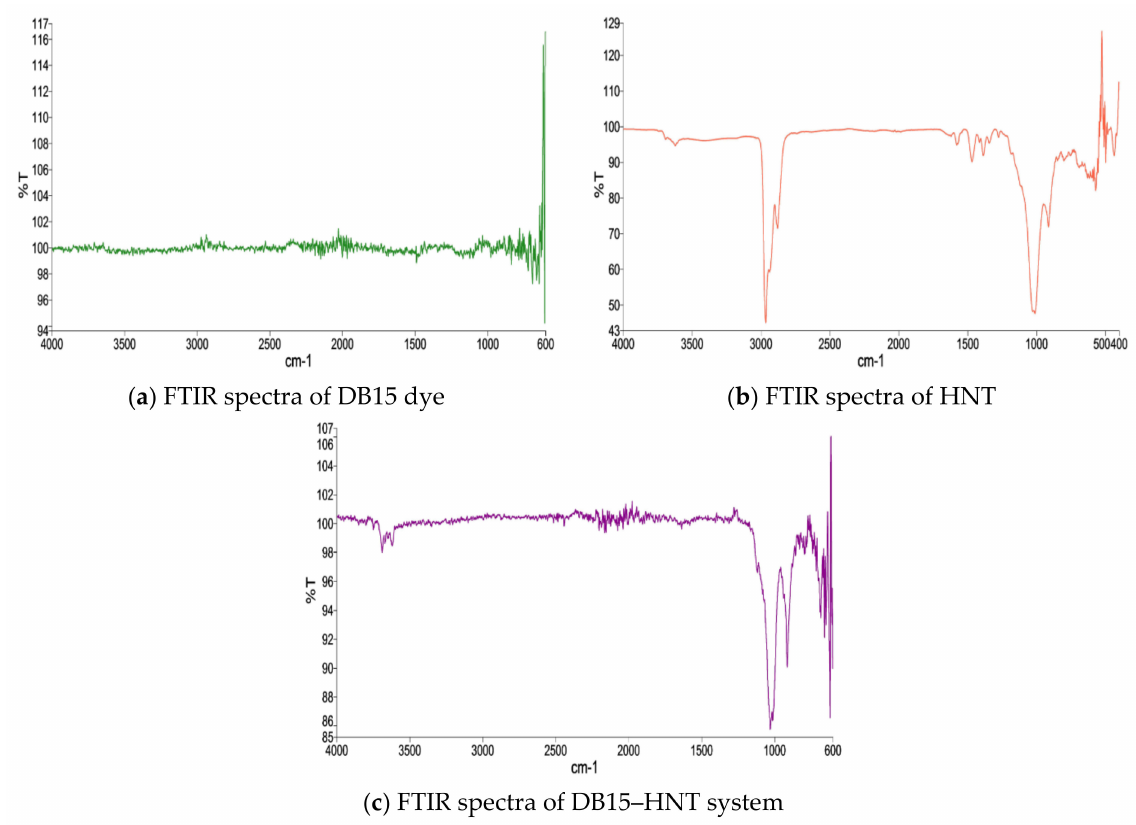
Figure 3. FTIR spectra of the samples under study.